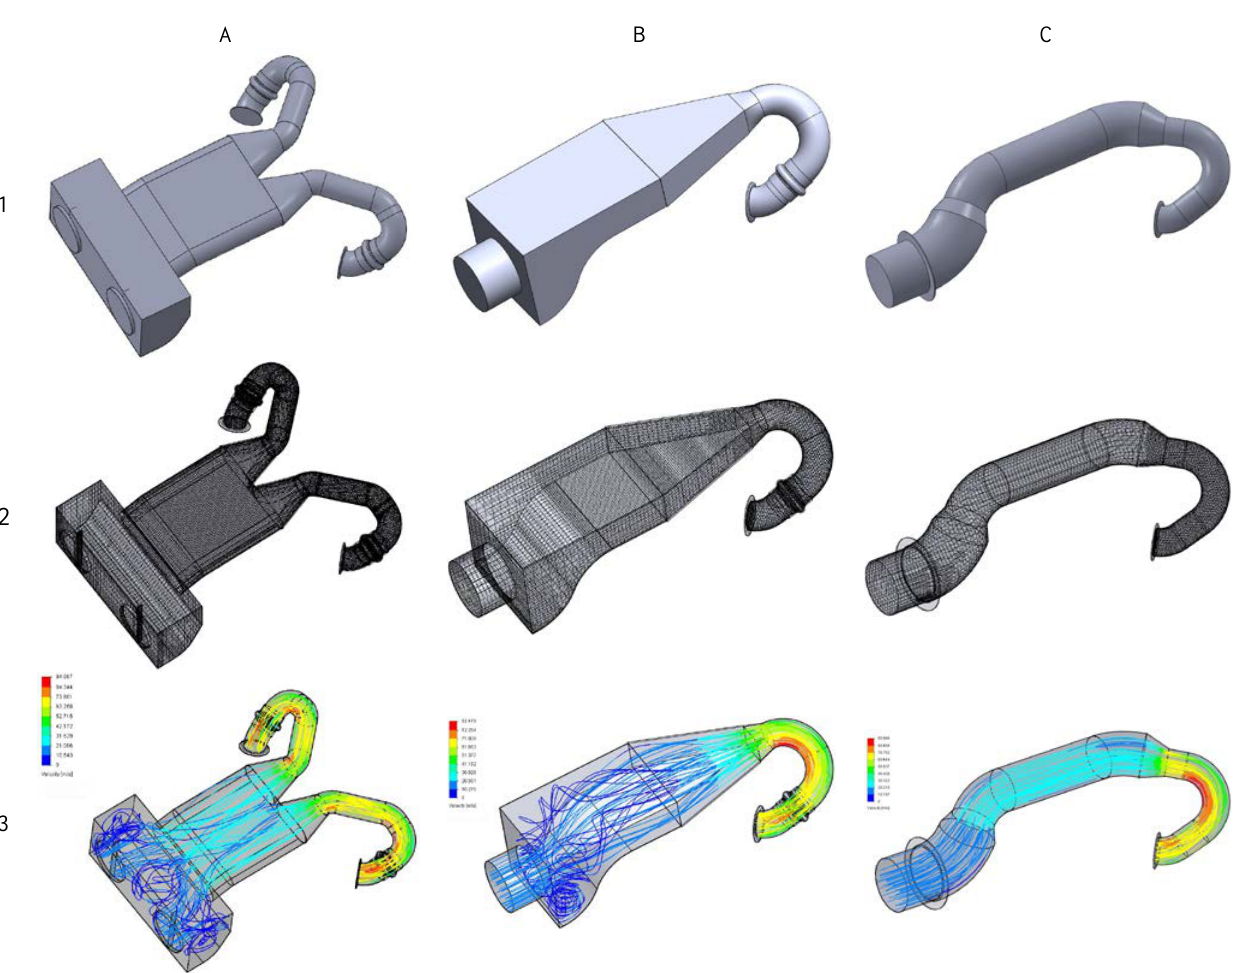
Fig. 11. CFD simulations of the intake systems in configurations A, B, and C of the 19D locomotive: 1 – numerical models, 2 – division of numerical models into finite elements, 3 – distribution of air